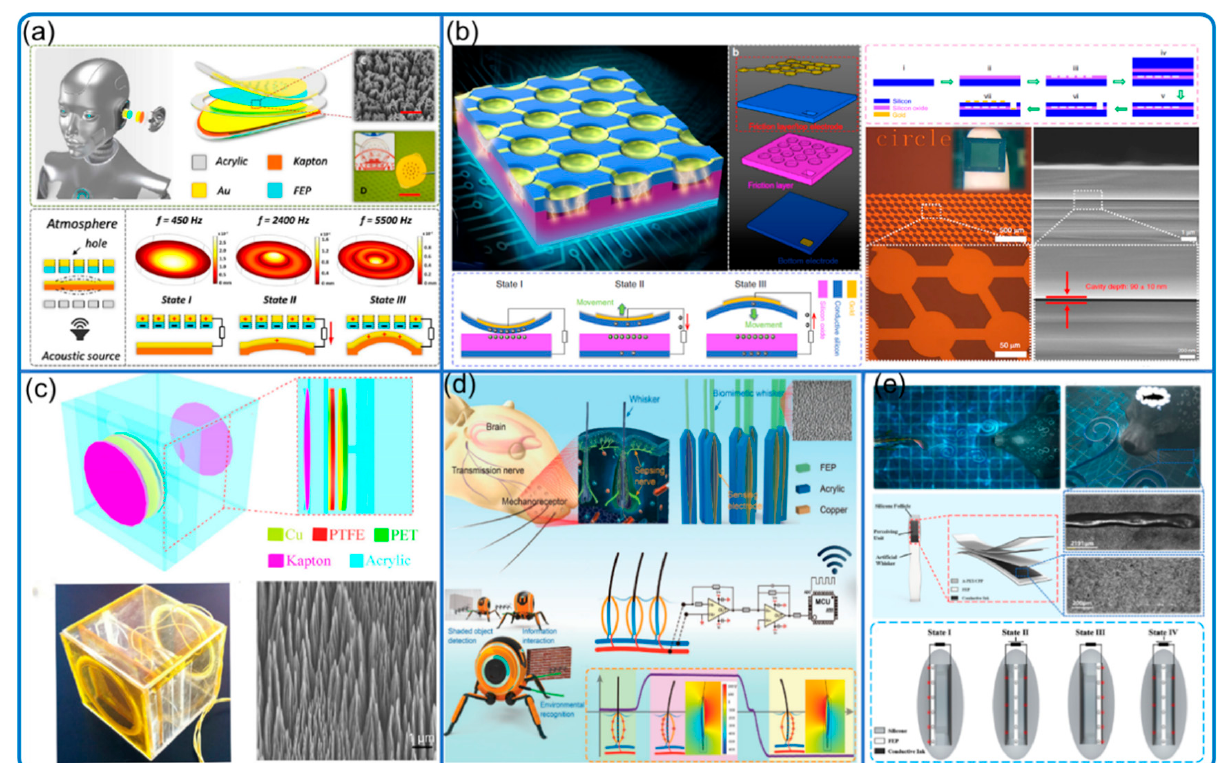
Figure 9. Remote media vibration sensor. ( a ) Auditory sensor. Reproduced with permission. Copy- right 2018, AAAS [67]. ( b ) Micro triboelectric ultrasonic device. Reproduced with permission. Copyright 2020, American Chemical Society [69]. ( c ) Acoustic source locator in underwater environ- ment. Reproduced with permission. Copyright 2015, Springer [70]. ( d ) Biomimetic hairy whiskers. Reproduced with permission. Copyright 2021, Wiley Online Library [71]. ( e ) Underwater bionic whisker sensor. Reproduced with permission. Copyright 2022, Elsevier [72].